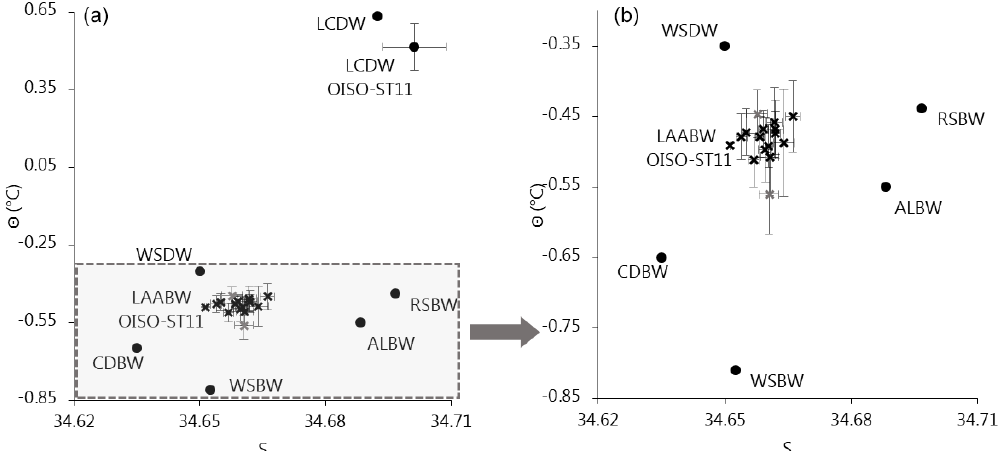
Figure 4. (a) Full (cid:50) – S diagram of studied water masses and (b) a zoom-in to bottom water. Values are from the literature for the WSBW (Fukamachi et al., 2010; van Heuven, 2013; Pardo et al., 2014; Robertson et al., 2002), the WSDW (Carmack and Foster, 1975; Fahrbach et al., 1994; van Heuven, 2013; Robertson et al., 2002), the RSBW (Fukamachi et al., 2010; Gordon et al., 2015; Johnson, 2008; Pardo et al., 2014), the ALBW (Fukamachi et al., 2010; Johnson, 2008; Pardo et al., 2014), the CDBW (Ohshima et al., 2013) and the LCDW (Lo Monaco et al., 2005a; Pardo et al., 2014; Smith and Treguer, 1994), as well as from the OISO-ST11 dataset for the OISO-ST11 LAABW and OISO-ST11 LCDW. Error bars are calculated from the individual annual averaged values for the OISO-ST11 LAABW and from all data for the OISO-ST11 LCDW. For the OISO-ST11 LAABW, the grey cross are the GEOSECS (lowest (cid:50) ) and INDIGO-1 (highest (cid:50) )